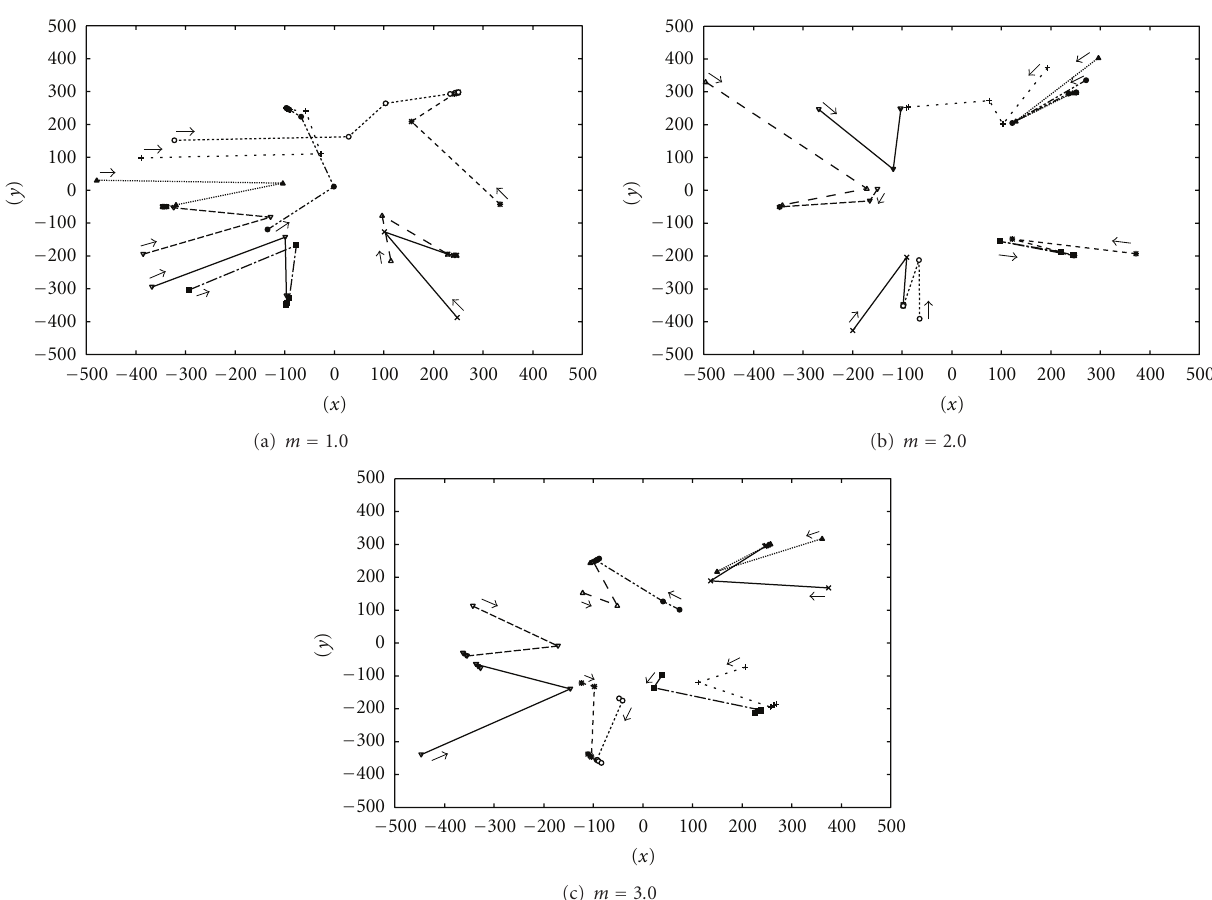
Figure 8: The shifts of cluster centers of Tsallis entropy based clustering with decreasing the temperature by VFA ( m = 1 . 0,2 . 0,3 . 0, q = 1 . 5). data because β is comparatively small and the membership function extends over the whole data area and is extremely uniform.